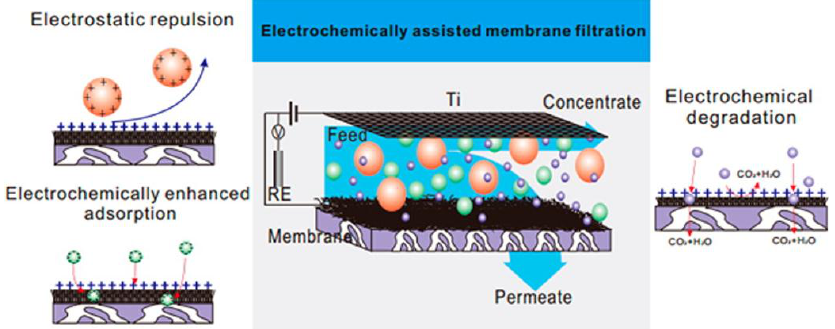
Figure 12. The separation mechanism of CNTs-Al 2 O 3 composite membranes under electrochemical assistance